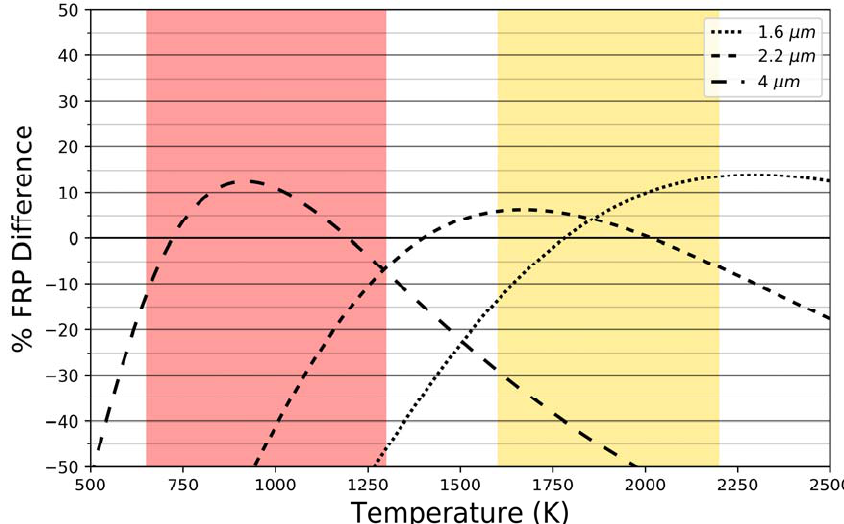
Figure 4. Bias in retrieved FRP as a function of temperature, for single-waveband FRP retrievals made at 1.6, 2.2 and 4 µm respectively using optimised FRP coefficients for gas flaring temperatures of 1600– 2200 K for the 1.6 and 2.2 µm channels and 650–1300 K landscape fire temperatures for the 4 µm